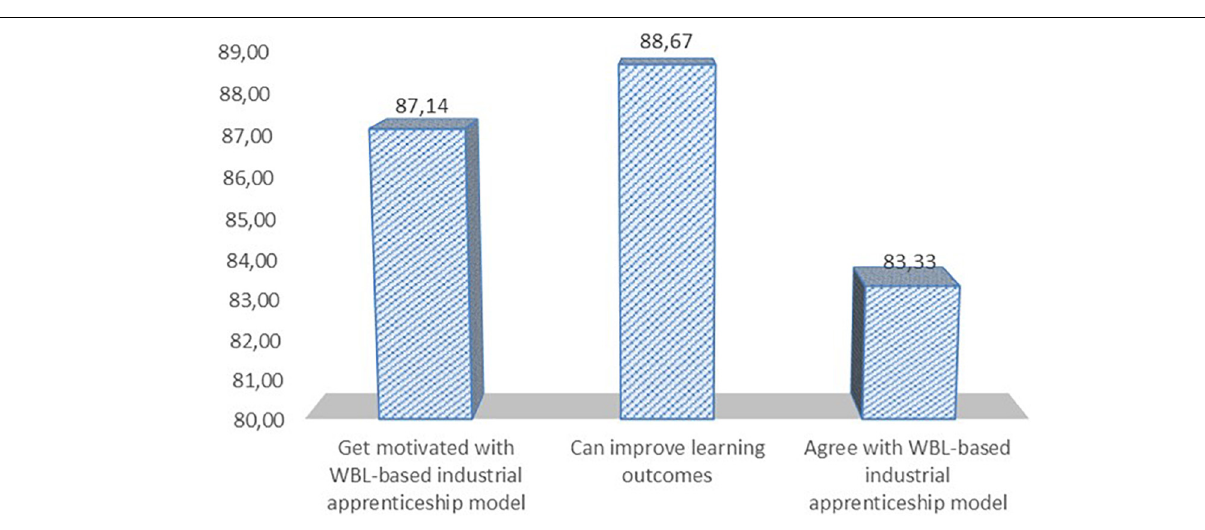
FIGURE 5 | Pre-service vocational teachers responses to the apprenticeship model